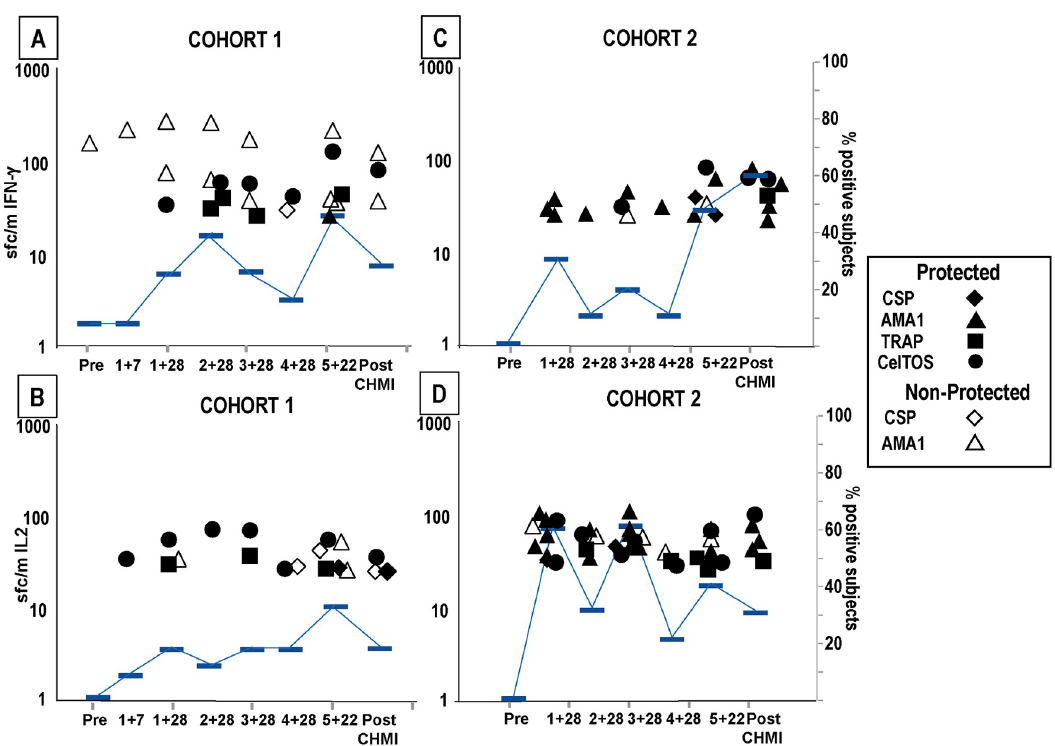
Fig 5. Cohort 1 and Cohort 2: IFN- γ and IL2 activities to CSP, AMA1, TRAP and CelTOS after each immunization and CHMI. IFN- γ and IL2 responses to CSP (diamonds), AMA1 (triangles), TRAP (squares) and CelTOS (circles) at pre-immunization (Pre), one week (1 � , Cohort 1 only) and four weeks post-1 st (1), post-2 nd (2), post-3 rd (3), five weeks post-4 th (4), 22–24 days post-5 th (5) immunizations, and 39–42 days post-CHMI (Post-CHMI). Protected subjects (closed symbols), non-protected subjects (open symbols). Percent of positive subjects, defined as any subject who had positive responses to one or more of the 4 antigens (blue bars). Some subjects were positive to more than one antigen. Panel A: Cohort 1: IFN- γ : responses peaked post-2 nd , dropped by post-4 th , rose post-5 th, and dropped post-CHMI. The only two subjects who had had IFN- γ responses to TRAP and CelTOS were both protected, and one protected subject had low responses to AMA1 post-5 th ; three non-protected subjects had responses to CSP and AMA1. Panel B: Cohort 1: IL2 : numbers of positive subjects remained low until they rose post-5 th ; two protected subjects had IL2 responses to TRAP and CelTOS, and one protected subject had low responses to CSP post-5 th ; three non-protected subjects had responses to CSP and AMA1. Panel C: Cohort 2: IFN- γ : responses rose post-1 st , dropped, and then rose post-5 th and post-CHMI; two protected subjects had responses to CSP, AMA1, CelTOS, and two additional subject had responses to CSP post-5 th ; the non- protected subject only had responses to AMA1. Panel D: Cohort 2: IL2 : more subjects had positive responses than IFN- γ responses, were variable during immunization and post-CHMI, and peaked post-1 st and post-3 rd ; seven protected subjects had IL2 responses to CSP, AMA1, TRAP and CelTOS, whereas the non-protected subject only had responses to